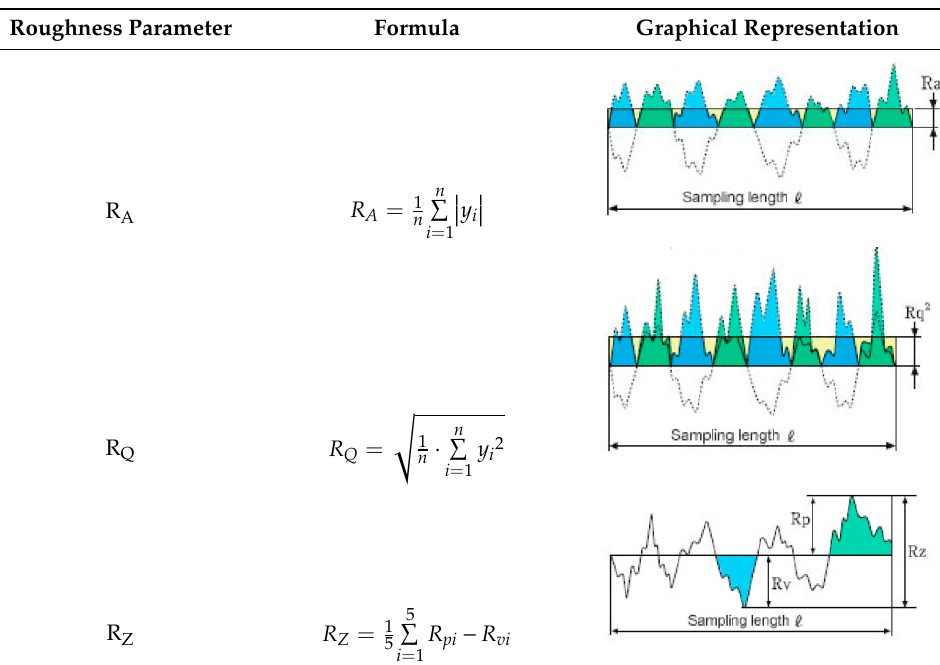
Table 3. Investigated roughness parameters.